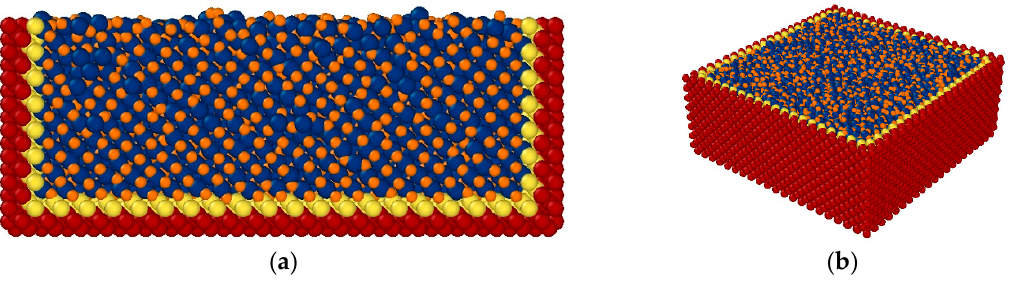
Figure 4. Molecular Dynamics Simulation Model of the LBMM Process on Silicon Carbide Substrate ( a ) Sectional view ( b ) 3-Dimensional view.